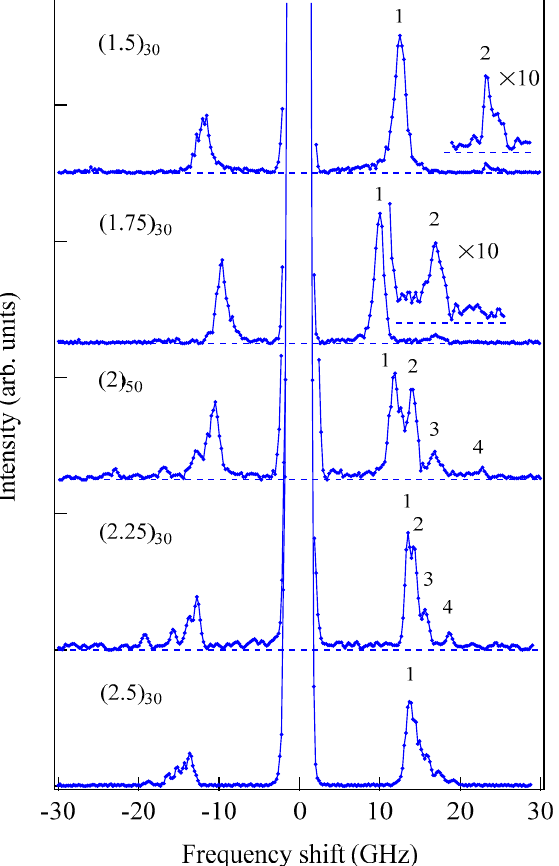
Figure 26. BLS spectra observed from 2 ± δ ML FLSLs ( δ = 0.25 and 0.5) at H = 3.0 kOe. The labels 1 to 4 stand for the corresponding SSW number [95].